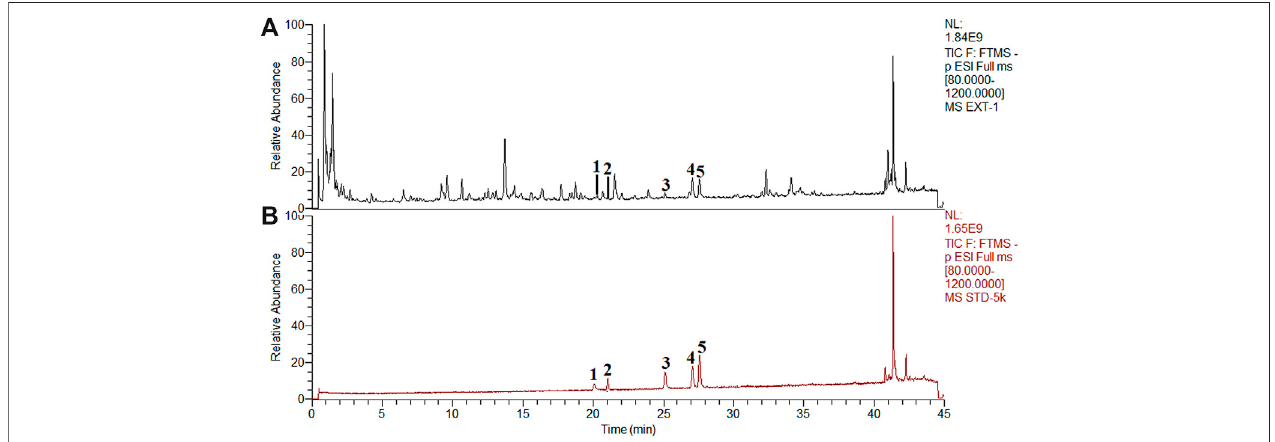
FIGURE 6 | Chemical analysis of POL by UHPLC-Q-Orbitrap HRMS. The typical fngerprint chromatograms of the extract of POL (A) and reference standards (B) . (1) Myricetin. (2) Quercetin. (3) Luteolin. (4) Kaempferol. (5) Apigenin.